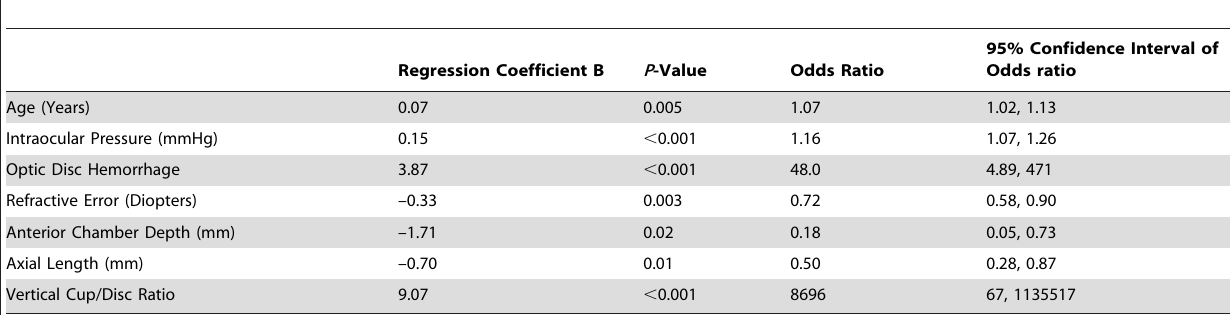
Table 3. Associations between the Prevalence of Angle-Closure Glaucoma and Systemic and Ocular Parameters (Multivariable Analysis) in the Central India Eye and Medical